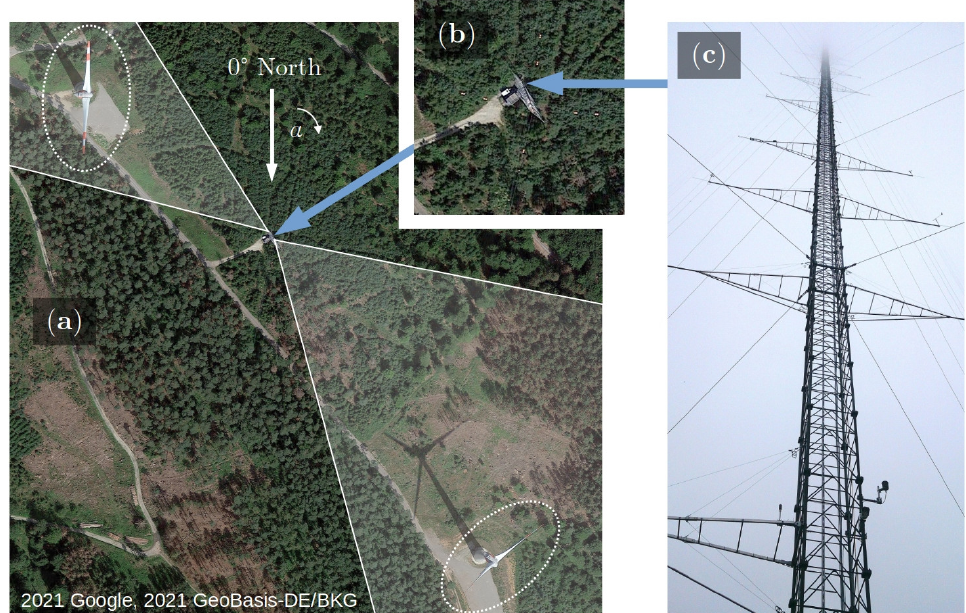
Figure 13. ( a ) Measurement site including two wind energy turbines located at 146 ◦ and 307 ◦ angles (a third wind turbine located south-east is not shown). Around the met mast, the areas corresponding to the wakes of the nearby wind turbines are highlighted between 100 ◦ to 165 ◦ and 285 ◦ to 330 ◦ angles. ( b ) Slightly larger view of the wind met mast and its orientation with respect to the measurement site. ( c ) Met mast with multiple booms mounted at different heights and at 145 ◦ and 307 ◦